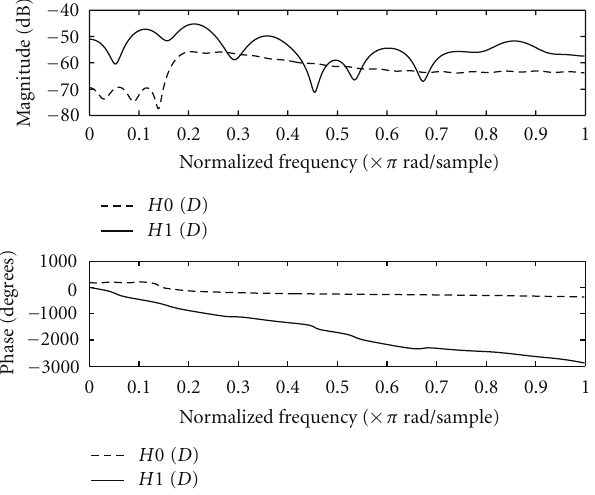
Figure 4: Frequency responses for channels H 0( D ) and H 1( D